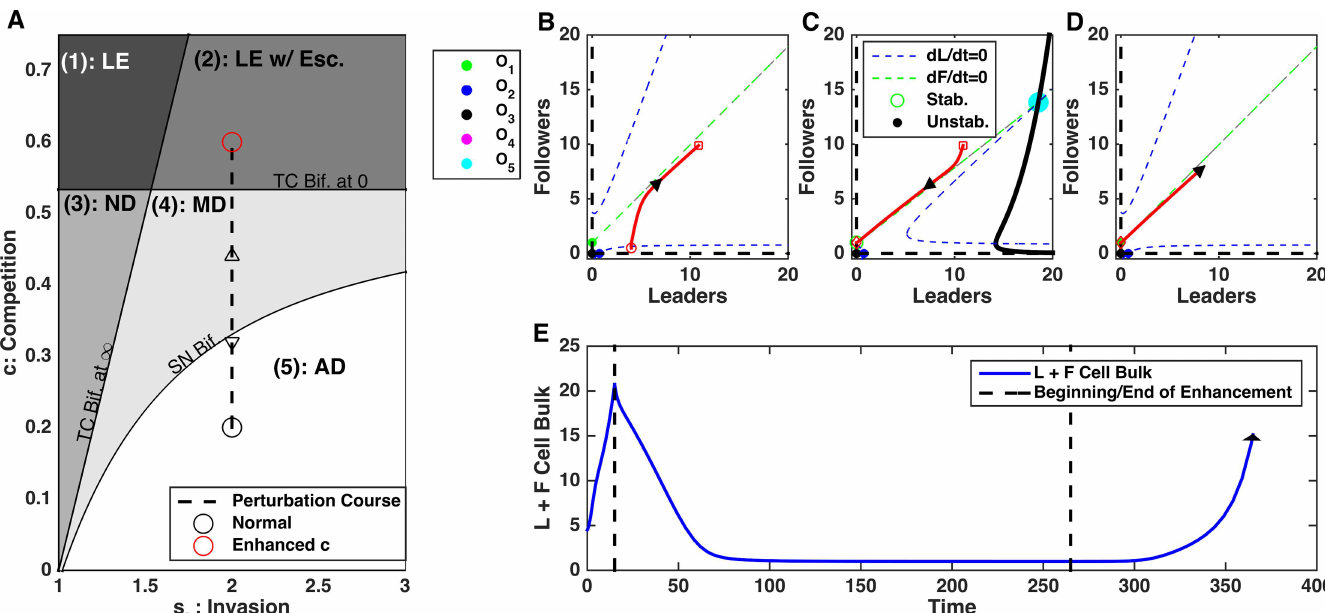
Fig 6. Enhancing competition between leader and follower populations can drive transient extinction of leaders. A) Bifurcation diagram depicting the direction of the perturbation—increase in competition, c . Black circle–initial state; red circle–perturbed state. B-D) Phase plots of dynamics before (B), during (C), and after (D) enhancement of competition. E) Time-course of cell count. Here, we assume total extinction of leaders occurs during treatment, i.e. at some point during treatment L = 0 . Note that ecosystem dynamics is reversed after perturbation is